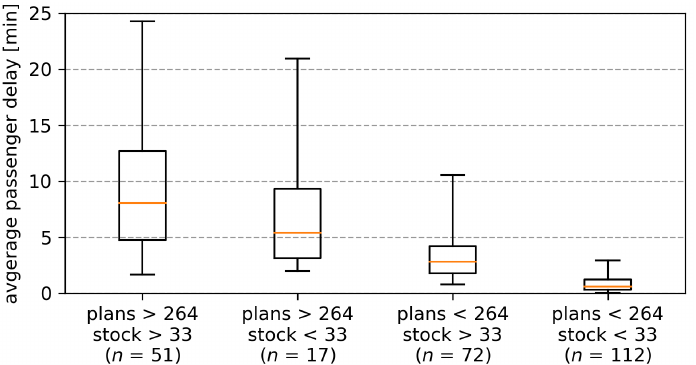
Figure 9. Four groups of scenarios based on their position related to the thresholds of PHCAP (plans = 264) and PICAP (stock = 33); the number n of scenarios falling into each category is listed in brackets.